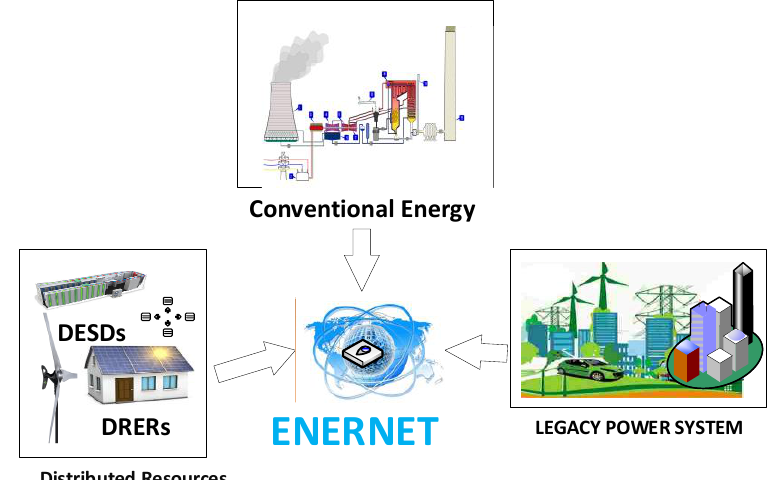
Figure 1. Vision of the energy Internet.